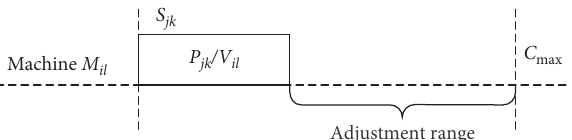
Figure 6: Adjustment diagram when O jk is the last operation on on machine M il and k � N j